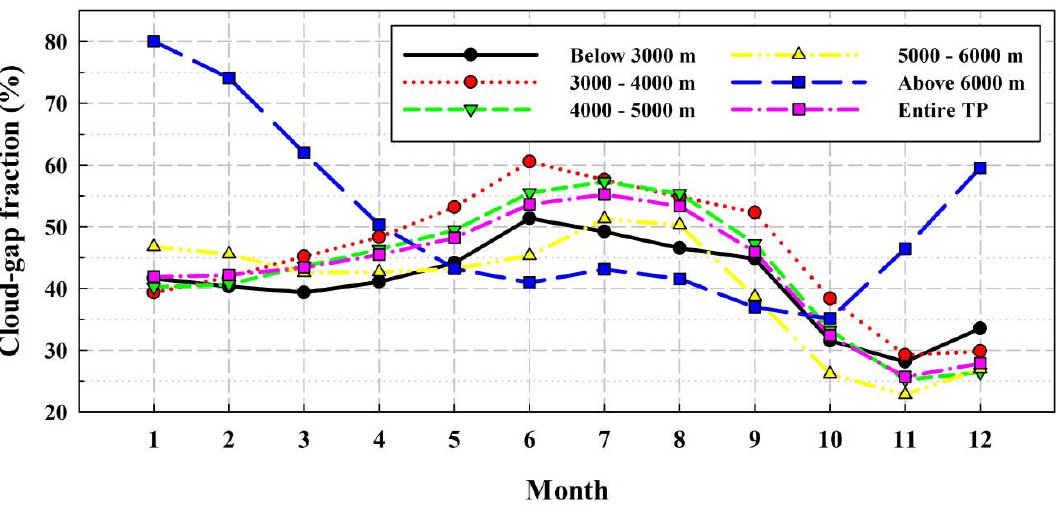
Figure 9. Monthly average cloud-gap fraction of MODIS Terra NDSI products in di ff erent elevation zones.